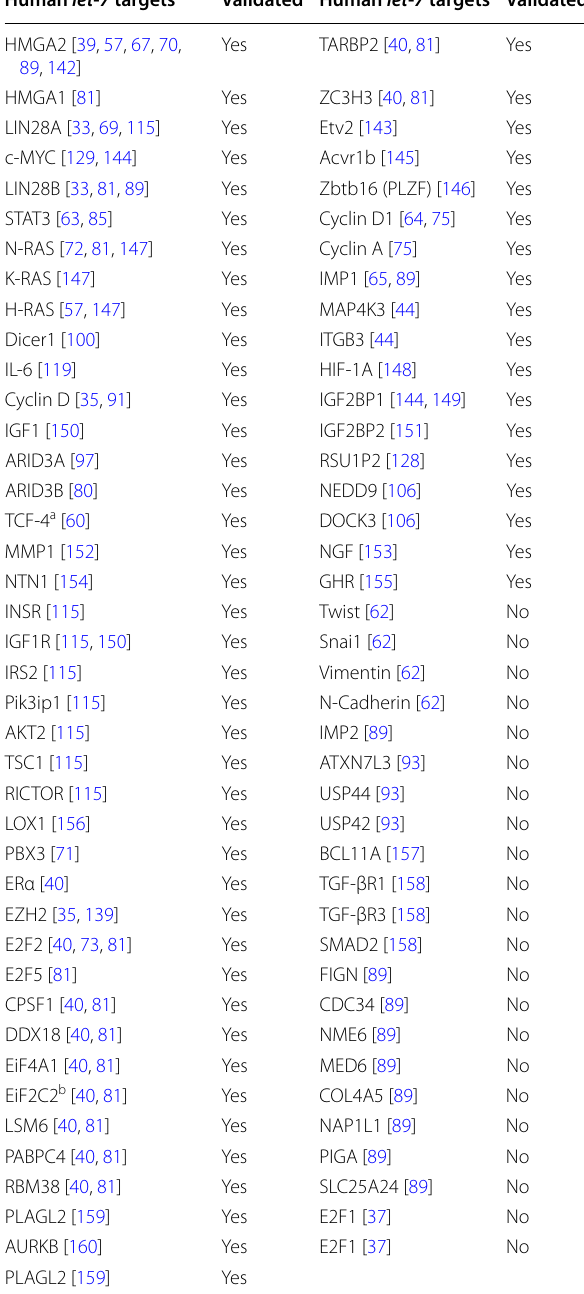
Table 4 Validated and non‑validated direct Let ‑ 7